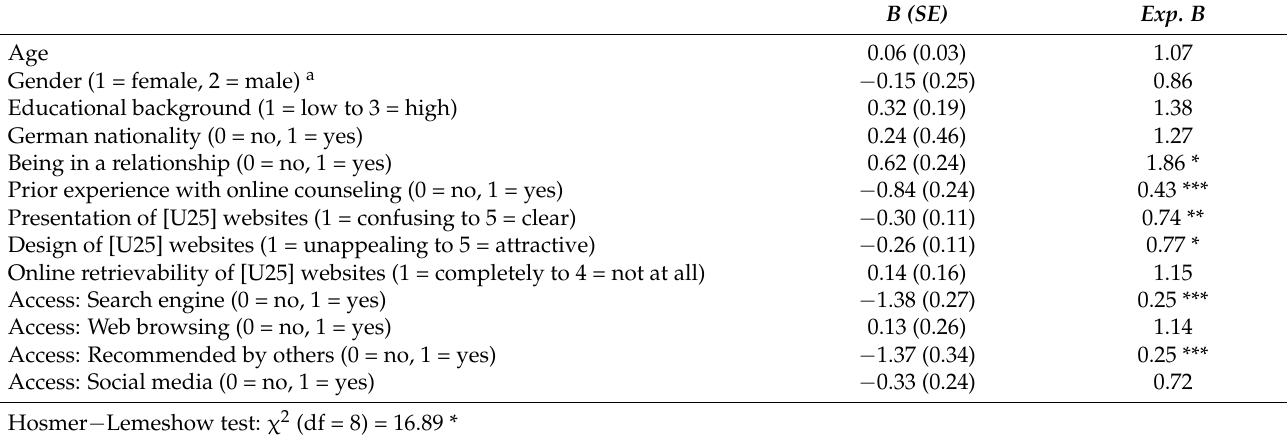
Table 2. Binomial logistic regression analysis to predict group assignment (0 = client vs. 1 = refuser; n =